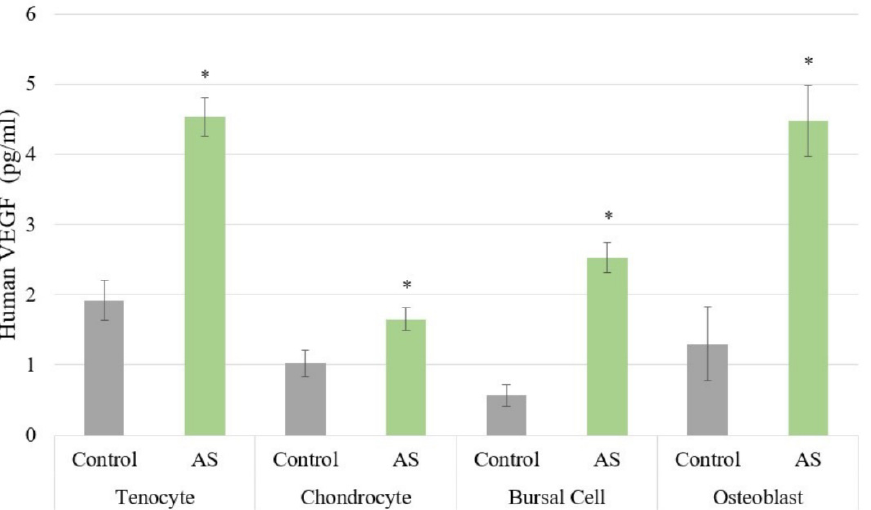
Figure 3. The protein expression of vascular endothelial growth factor (VEGF) was significantly increased in all cell lines treated with activated serum compared to control. Statistical significance ( p < 0.001) denoted by *. AS, Activated Serum.